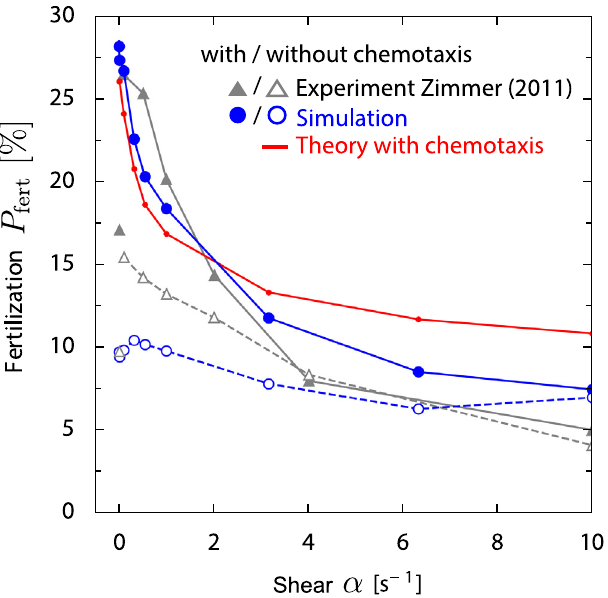
Fig 3. Comparison to experiment at moderate shear rates and short exposure time. Fertilization probability P fert ( α ) that an egg becomes fertilized as function of external shear rate α from previous experiments with red abalone H. rufescens gametes in a Taylor-Couette chamber (filled gray triangles: with chemotaxis, open gray triangles: inhibited chemotaxis; for α = 0 s − 1 a different experimental protocol was used) [20] and our corresponding simulations (filled blue circles: with chemotaxis, open blue circles: without chemotaxis, mean ± SD). We find reasonable agreement using a single fit parameter, fertilizability p f � 60%, which characterizes the fraction of sperm-egg encounters that result in successful fertilization, see Eq (5). From the experimental protocol, we estimate a background concentration c bg * 4 nM of chemoattractant. While our theory of filament surfing does not directly apply due to this high background concentration, a near-field estimate (red line) yields a similar decay of fertilization probability as function of shear rate α . The single fit parameter of the theory, j out = 4.8 � 10 3 m − 2 s − 1 , is again consistent with the limit j out = ρ egg v h /4 = 7.5 � 10 3 m − 2 s − 1 of a ballistic swimmer with random initial conditions (note the the higher value of j out compared to Fig 2 due to higher egg density). For simplicity, simulations do not account for co-rotation of sperm cells, see Fig A in S1 Text for results with